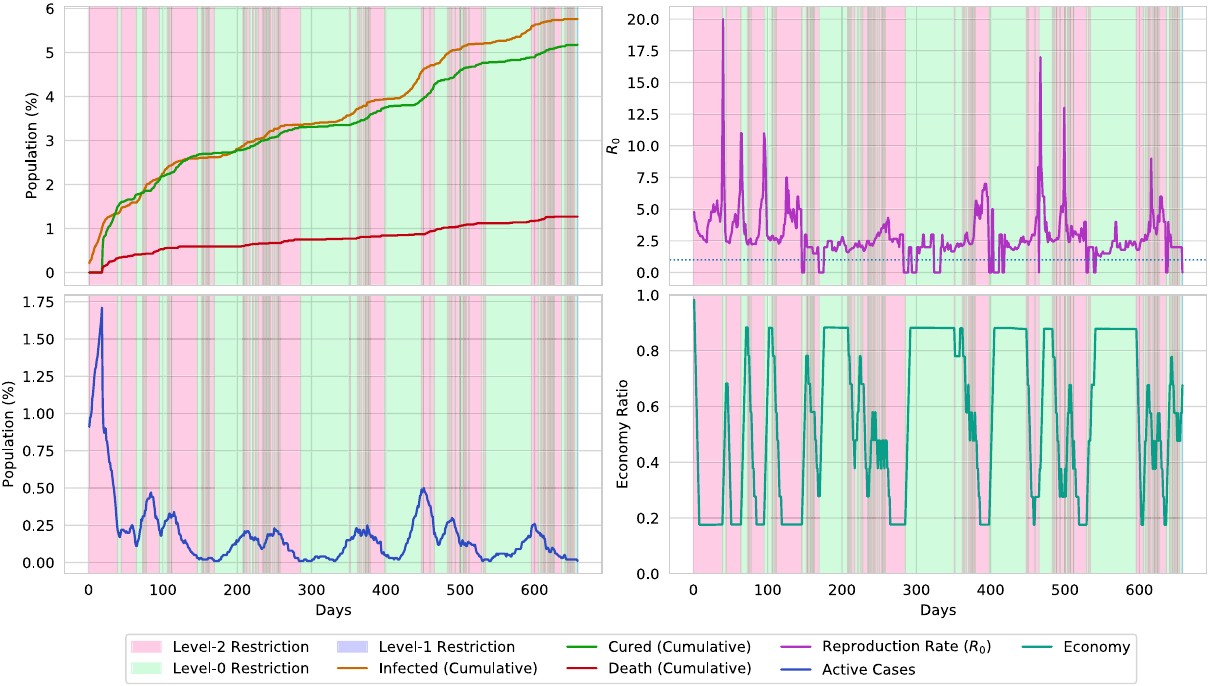
Figure 19. The graphs represent the movement restrictions provided by the agent. The red region of the graph denotes the days when a lockdown is placed. The green region of the graph denotes the days when no lockdown is placed. In the early stage of the environment, the agent places multiple 20–40 days lockdown to reduce the spread of the disease. In the later stage, to control the resurgence of the disease, the agent performs a cyclic lockdown (1–3 days cycle) followed by a 10–15 days lockdown to reduce the future spread of the virus. It can be also analyzed that the agent mostly follows this pattern when both the active cases percentage and the reproduction rate is